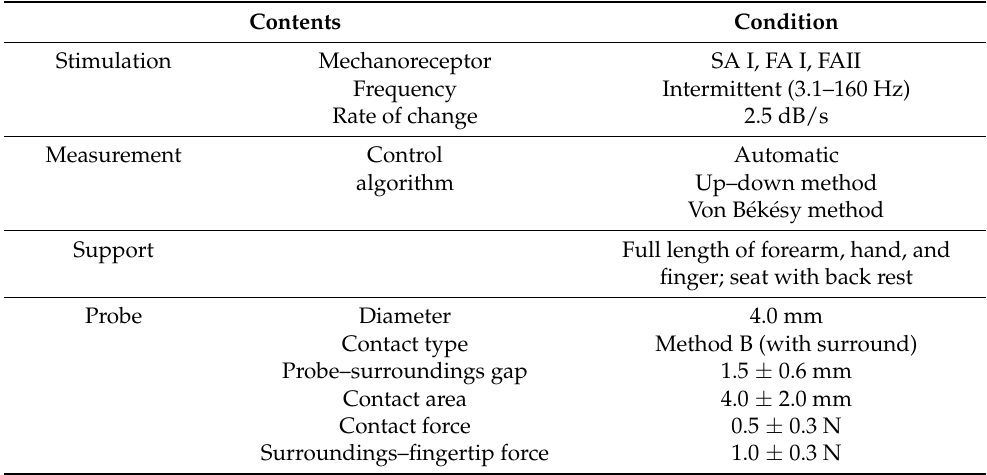
Table 2. Specifications of the vibrotactile perception meter used in this study.